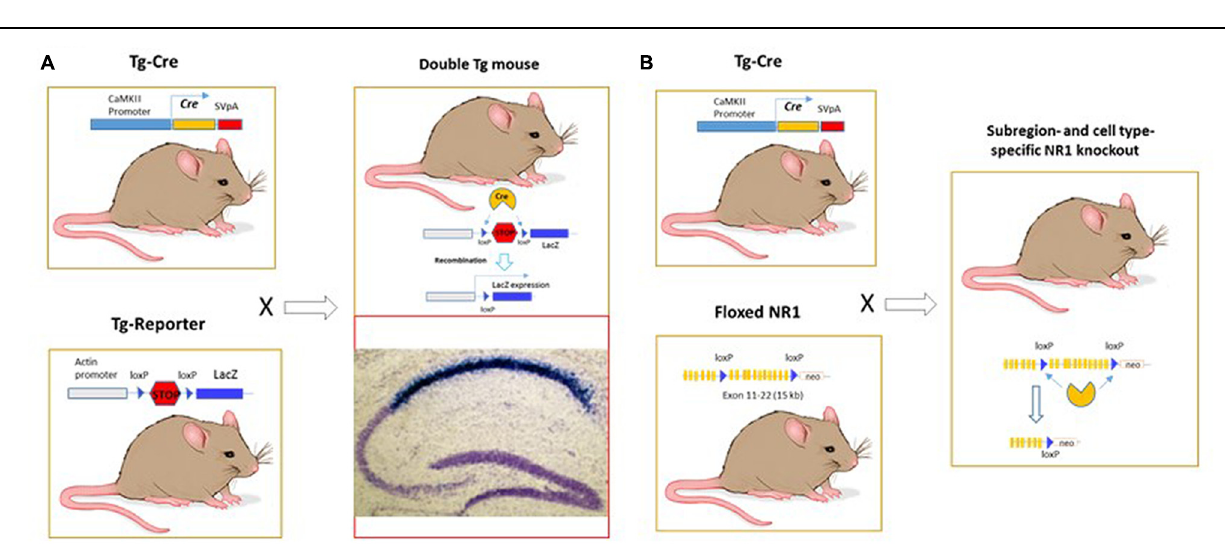
FIGURE 2 | Cre-LoxP neurogenetics for achieving region- and cell-type specific analysis of relationships of genes, circuits, and functions in the brain. (A) Strategy to detect the Cre-LoxP recombination in the brain. It required the production of two different transgenic mice: Tg-Cre and Tg-Reporter lines, respectively. These two lines were then crossed to generate the double transgenic mice. CA1-specific recombination was detected after P19 by LacZ method. It is known that CA1 pyramidal cells undergo neurogenesis between E10 and E18 and enter the post-mitotic state by P0. They are well differentiated by P7, with fully established synaptic connections. We have found that Cre-loxP recombination occurs during the middle or end of the third postnatal week in the CA1 pyramidal cells. LacZ in the CA1 pyramidal cells was detected as deep blue color on Nissl stain (in purple-blue) background. (B) Conditional knockout of NR1 gene in a specific cell type and region. The exon 11-21 encoding the entire transmembrane domain and C-terminus were flanked by the loxP (termed floxed) in the introns. The second loxP was followed with the neo cassette gene, which allowed for targeted ES cells selection. Luckily, insertion of loxP sites and the neo gene did not alter NR1 gene expression in the floxed homozygous